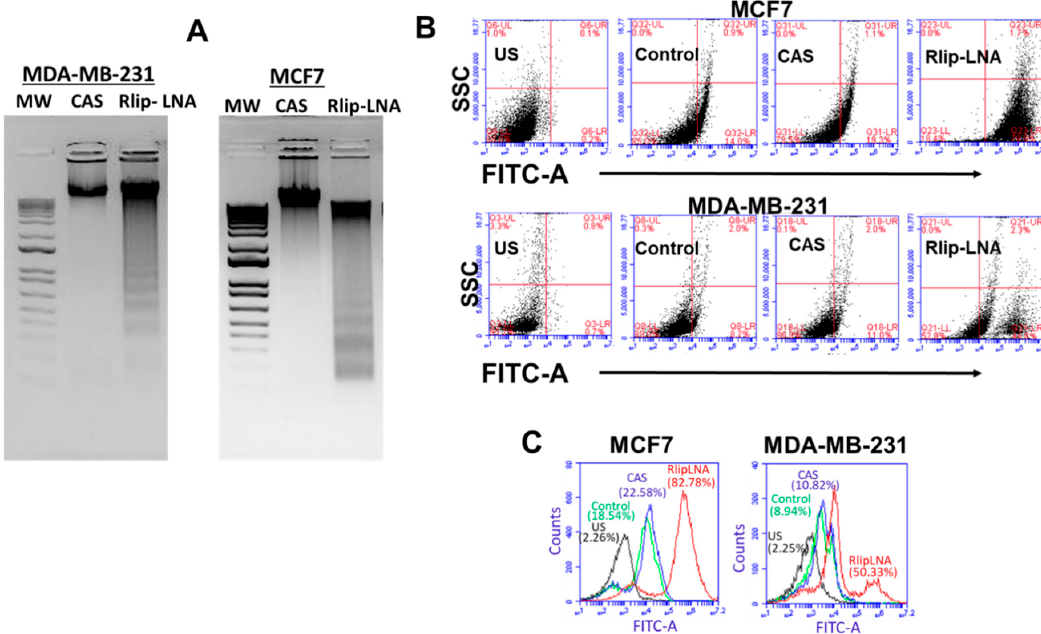
Figure 3. Effect of Rlip-LNA on apoptosis and DNA fragmentation in MDA-MB-231 and MCF7